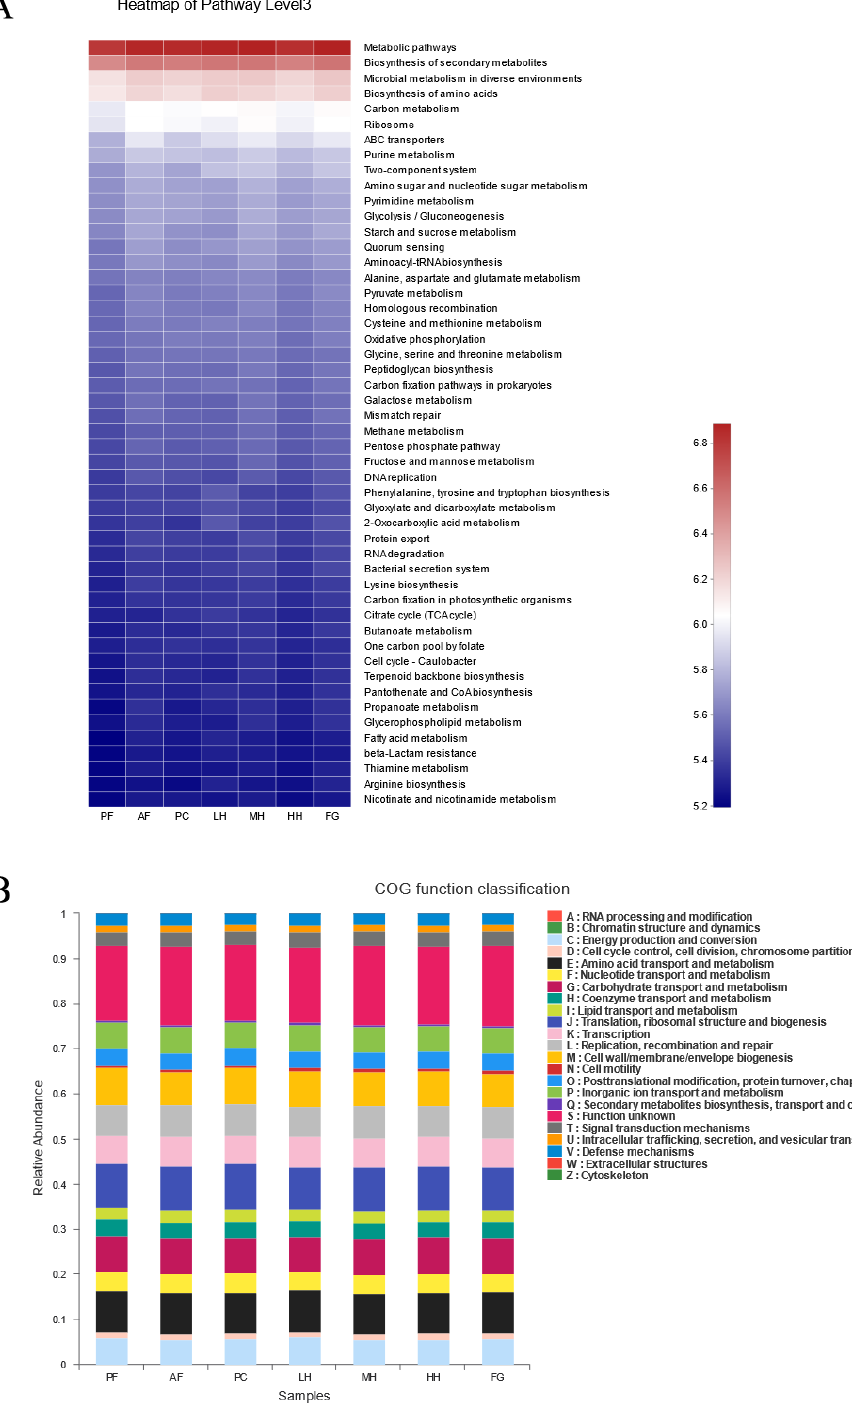
Figure 4. ( A ) Heatmap of major pathways in the KEGG database at level 3, based on PICRUSt anticipated functions of the gut microbiota; the colors span from blue to red. ( B ) The relative abundances of gut microbiota in the classification of the COG function. Note: PF represents the pair – fed control group. AF represents the alcohol – fed model group. PC represents the positive control group. LH represents the low – dose citrus honey group. MH represents the medium – dose citrus honey group. HH represents the high – dose citrus honey group. FG represents the fructose syrup group.